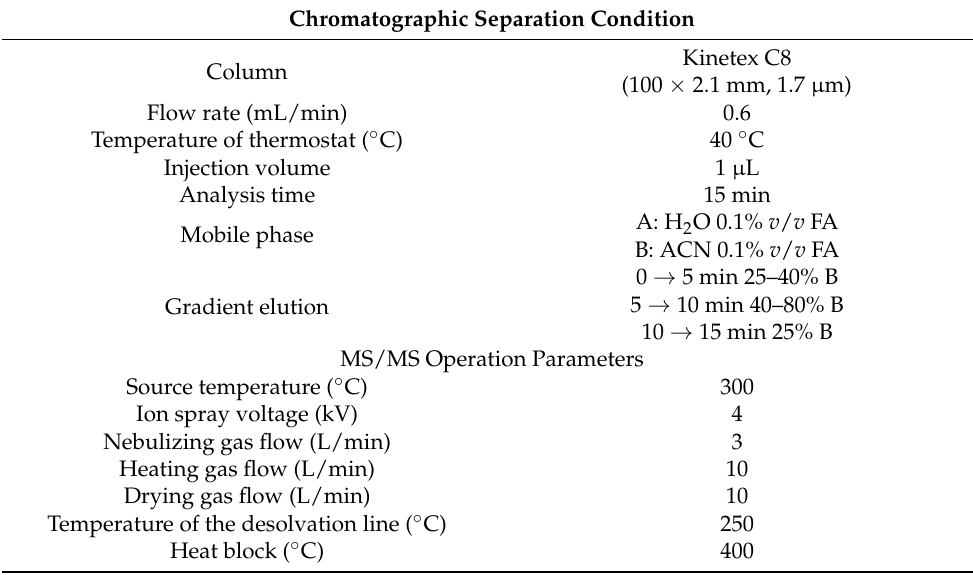
Table 2. The chromatographic separation conditions and MS/MS operation parameters .